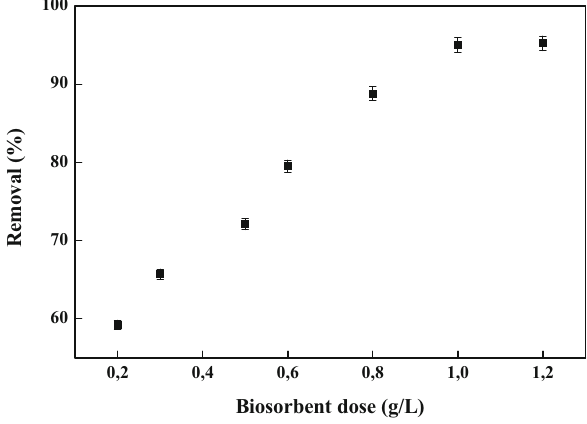
Fig. 4 Diazinon biosorption on pre-treated coffee waste (PCW) at different pHs